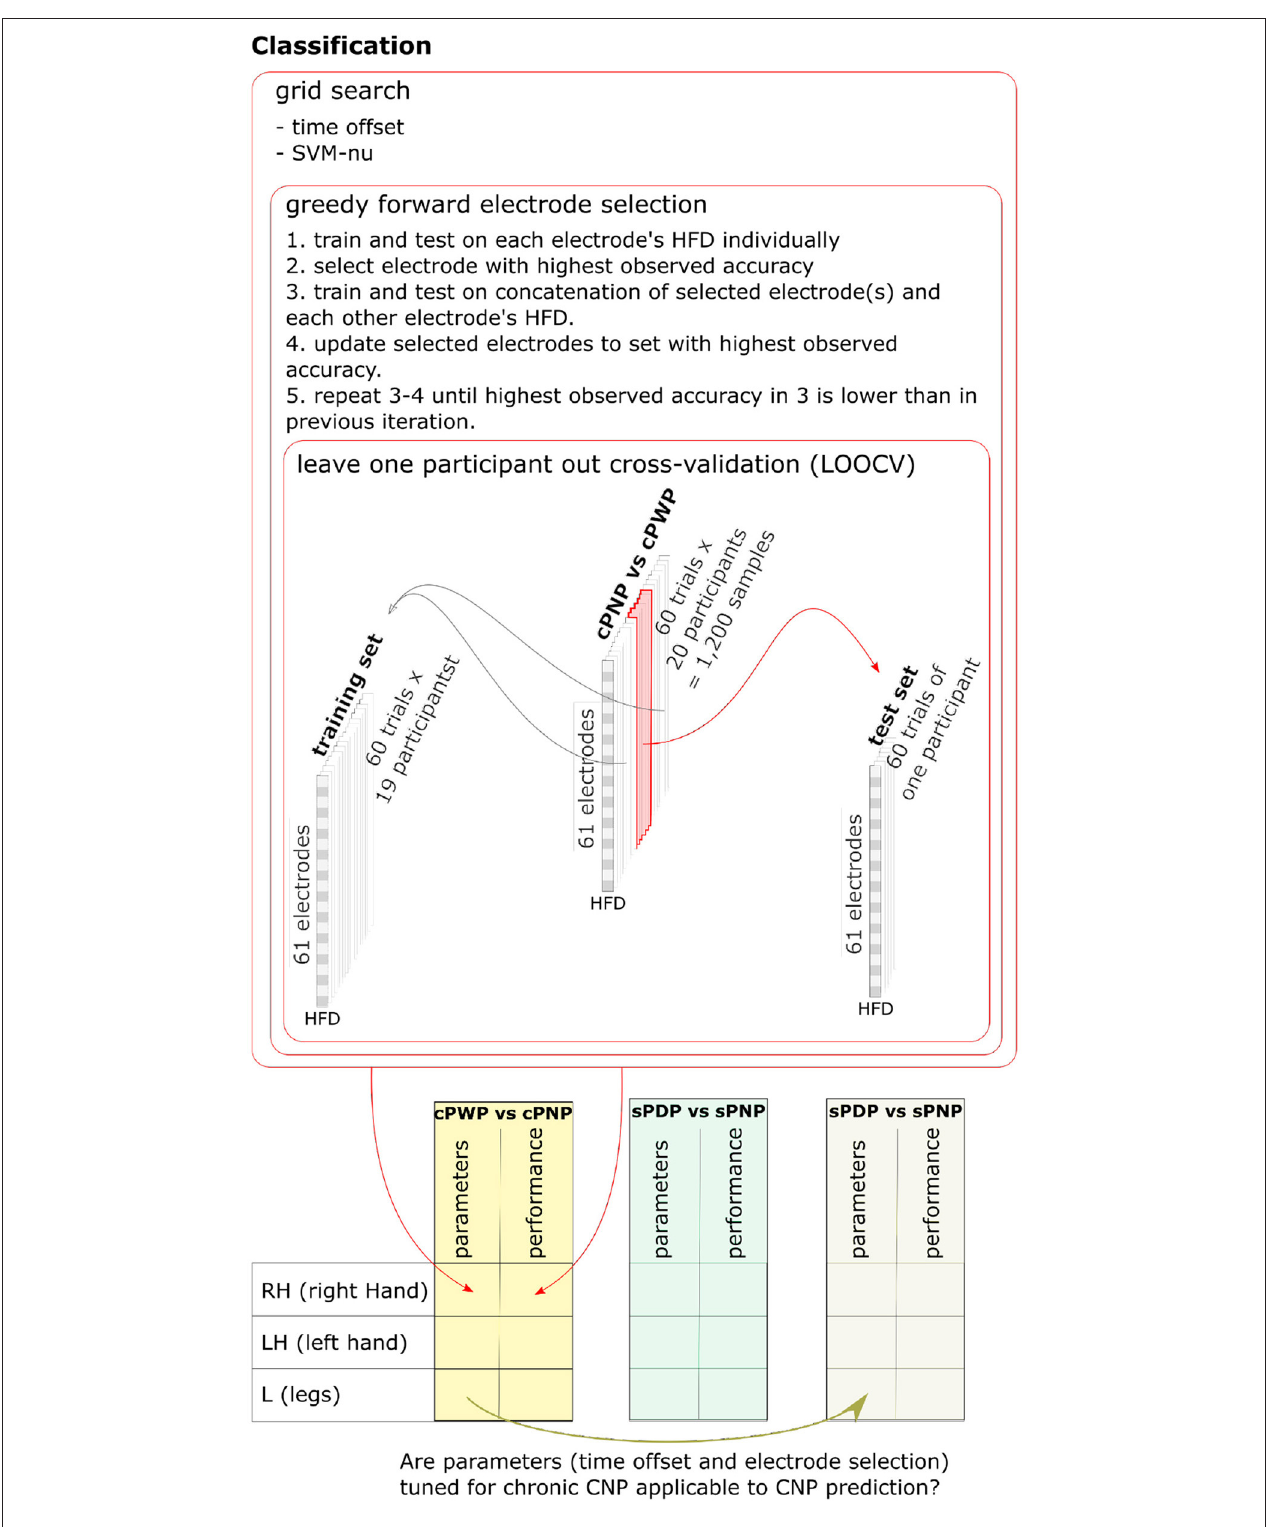
FIGURE 6 | Nested training procedure (top) and enumeration of all pair-wise classifiers (bottom) . Nested leave-one-subject-out-cross-validation is used to estimate classifier generalisation performance. Hyper-parameters are optimised using grid search and cross-validation on the training set, with greedy forward selection of electrodes used as input to the classifier. One pairwise classifier for each MI task was trained on Dataset 1 (cPWP vs. cPNP) and on Dataset 2 (sPDP vs. sPNP). We also explored whether additional knowledge gained from diagnostic classifier training can be transferred to the prognostic classifier, by using channels and time-window offsets that performed best on cPWP vs. cPNP to optimise classifiers on sPDP vs. sPNP. See section 2.4 for details.